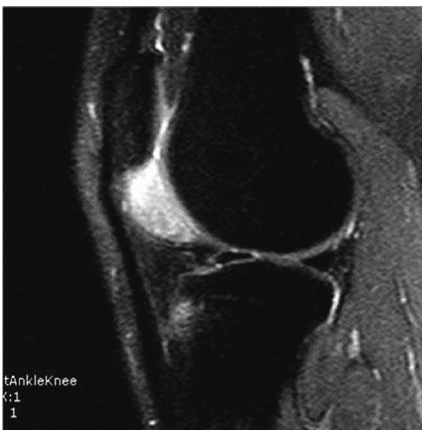
Figure 2: Hyperintense lesion in infrapatellar region on T2- weighted MRI sequences.